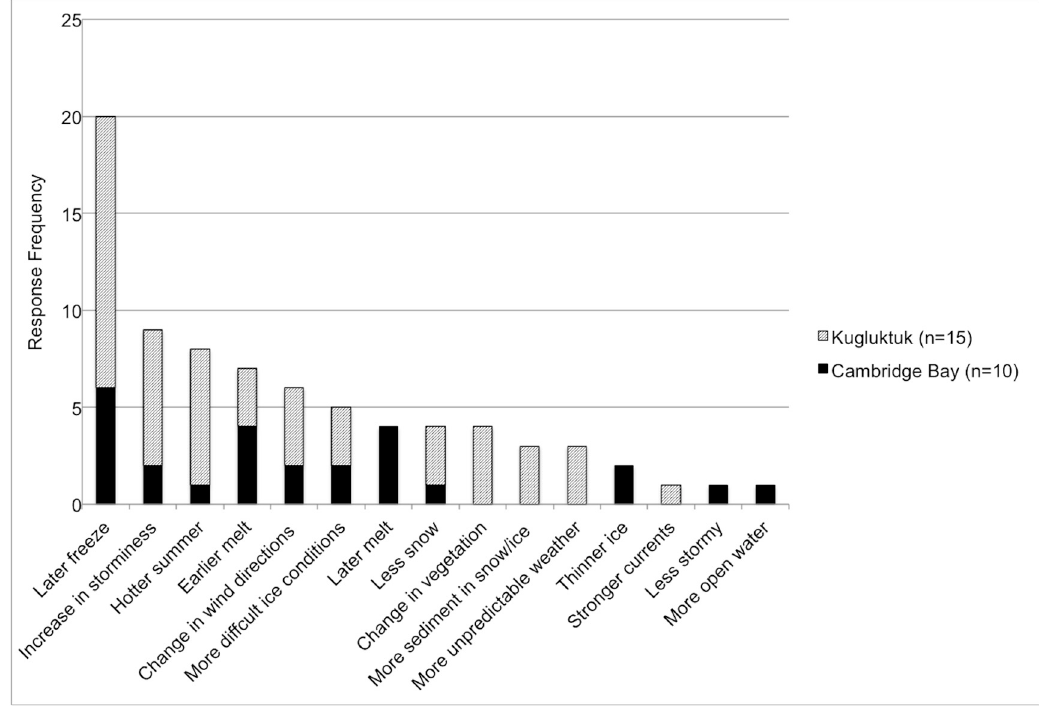
Figure 1. Environmental changes observed by participants in Cambridge Bay and Kugluktuk.